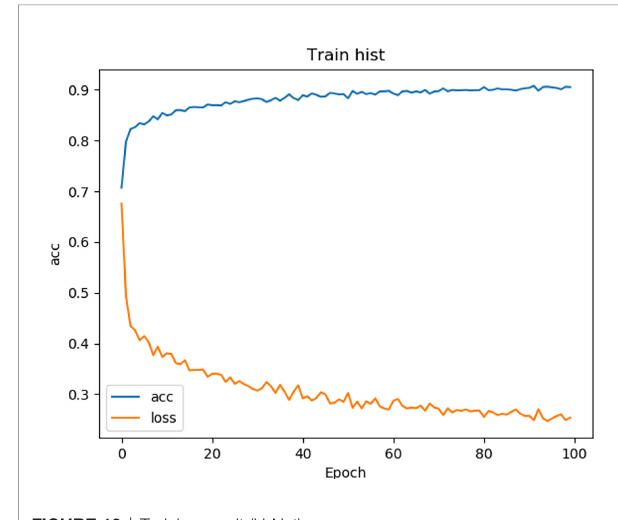
FIGURE 9 | Calculation method of DSC. (A) segmentation result, (B) label. FIGURE 10 | Training result